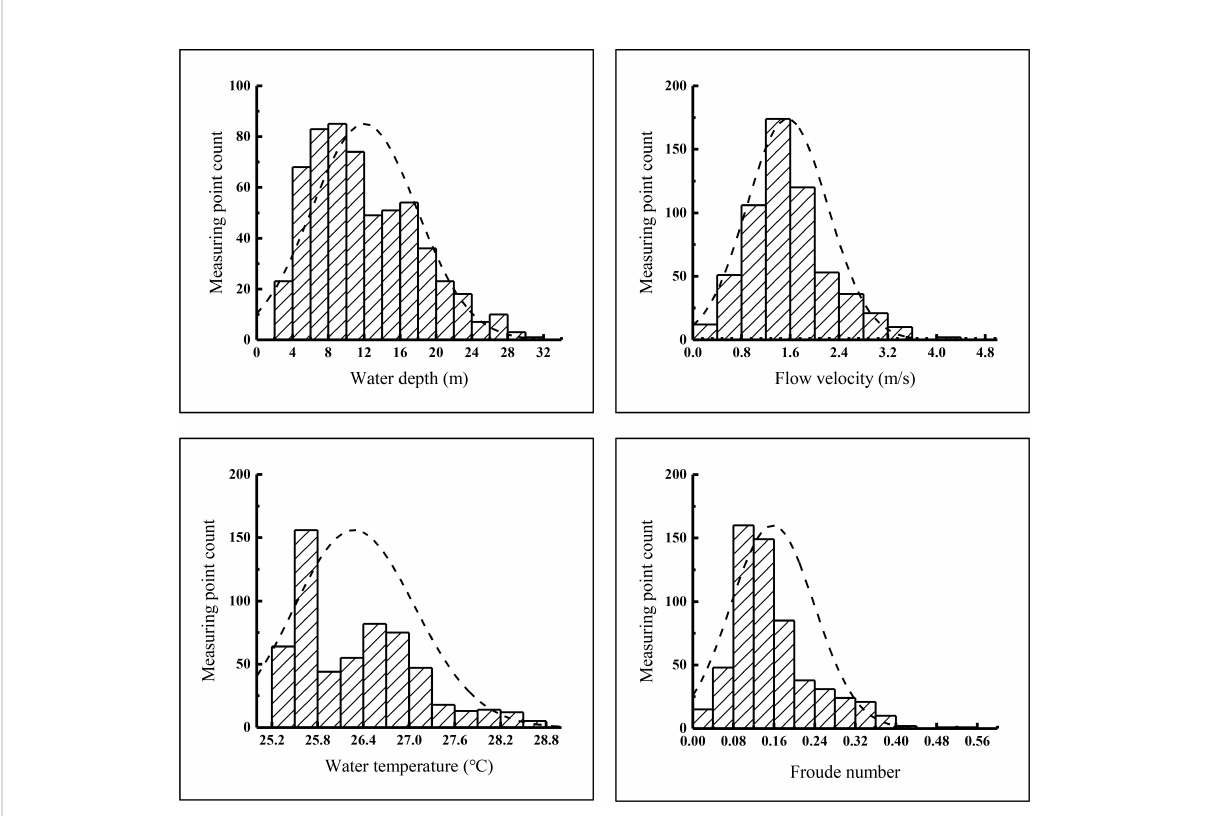
FIGURE 5 Water depth, fl ow velocity, water temperature, and Froude number data segmentation observed during spawning.